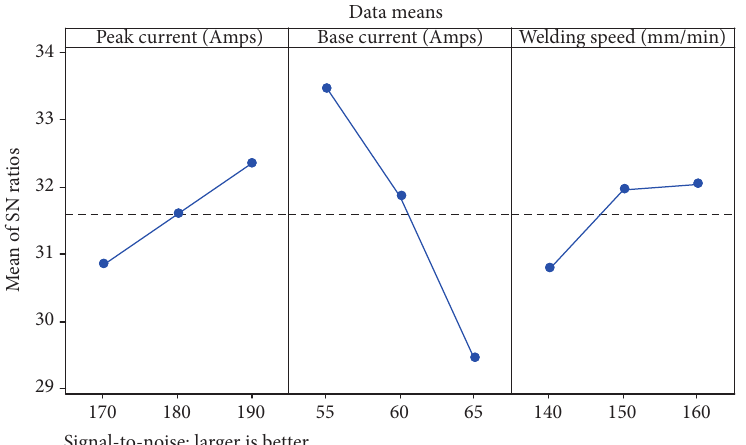
Figure 14: Main effect plot for S/N ratios.